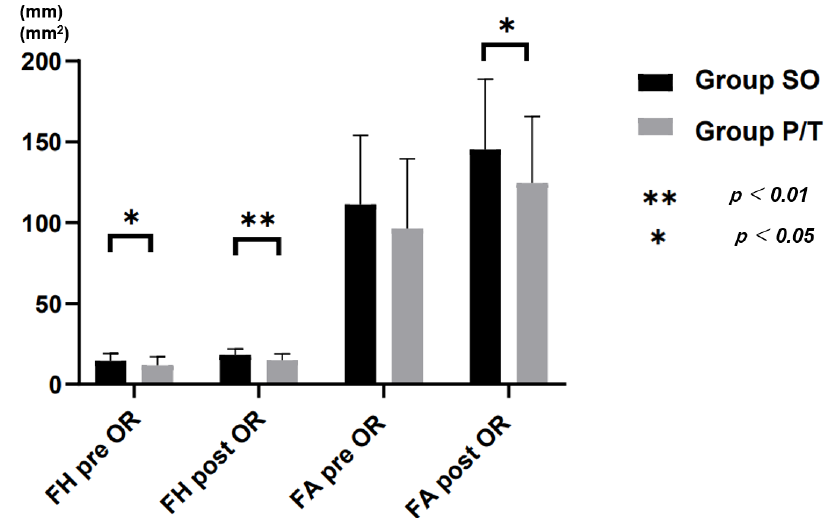
Figure 6. Radiological result . FH: foraminal height; FA: foraminal area; OR: operation.